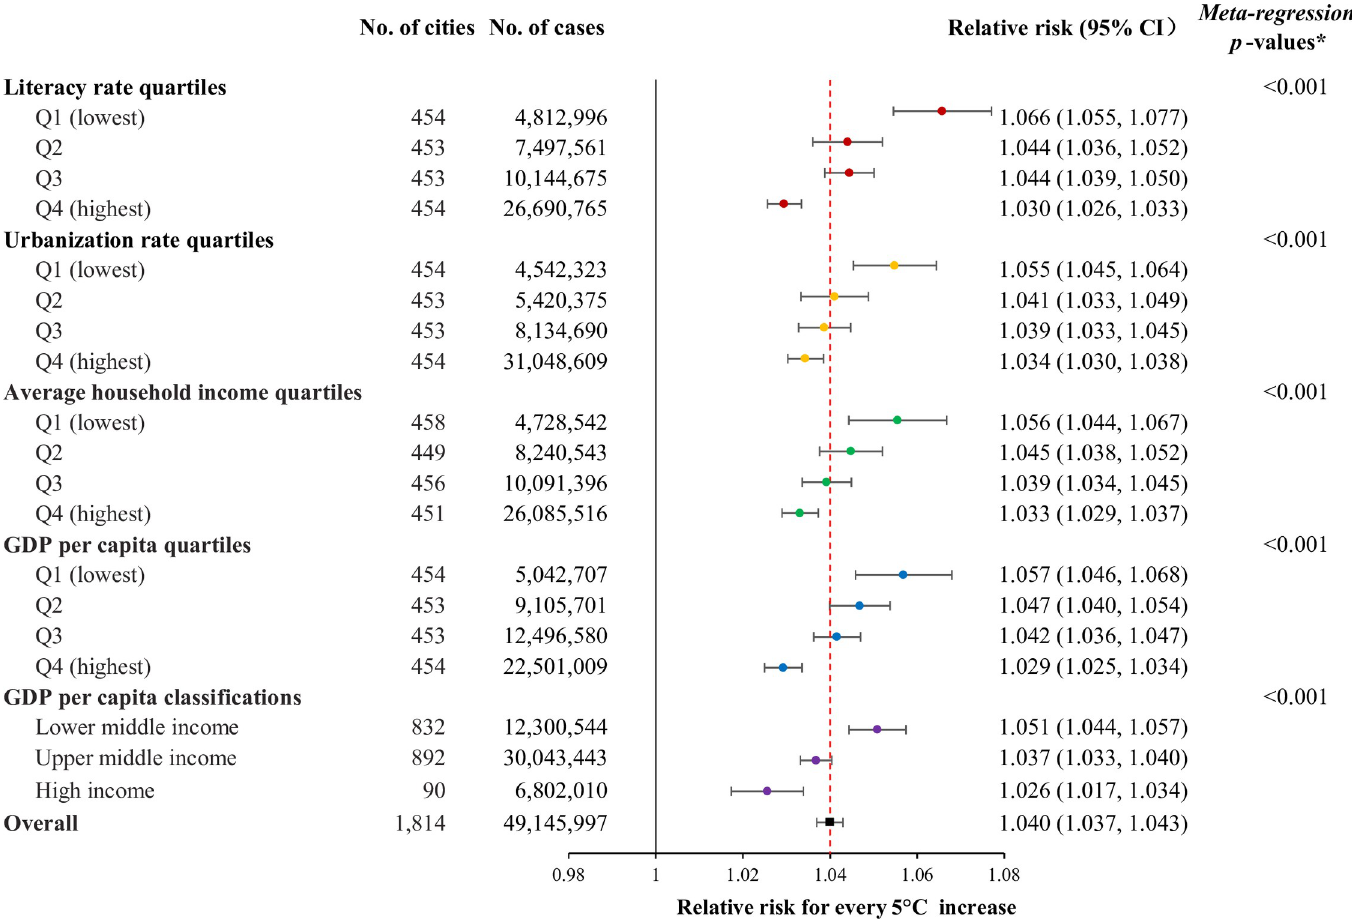
Fig 2. The association between heat exposure (for every 5˚C increase in daily mean temperature) and all-cause hospitalization during lag 0–7 days, stratified by socioeconomic level. Q1–Q4 represent 4 quartiles from the lowest to the highest. GDP per capita classifications were based on the World Bank’s 2015 standard. � The meta-regression P values were derived from the meta-regressions modeling the 1,814 city-specific effect estimates against the city-level literacy rate, urbanization rate, average household income, and log(GDP per capita) separately (see Fig C in S2 Text). CI, confidence interval; GDP, gross domestic product.